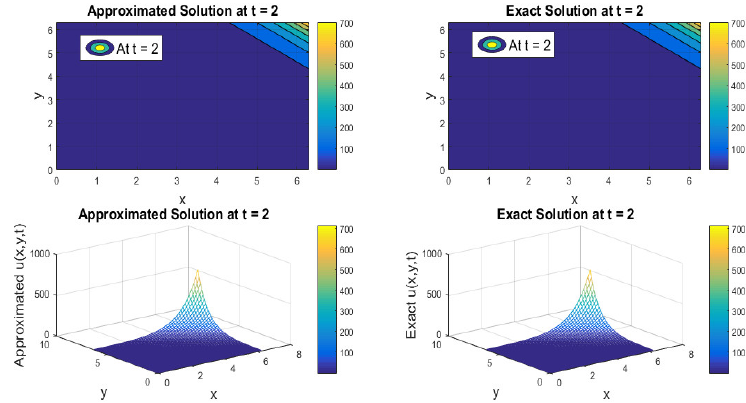
Figure 7. Comparison of approx. and exact profiles at t = 2 regarding Example 6.